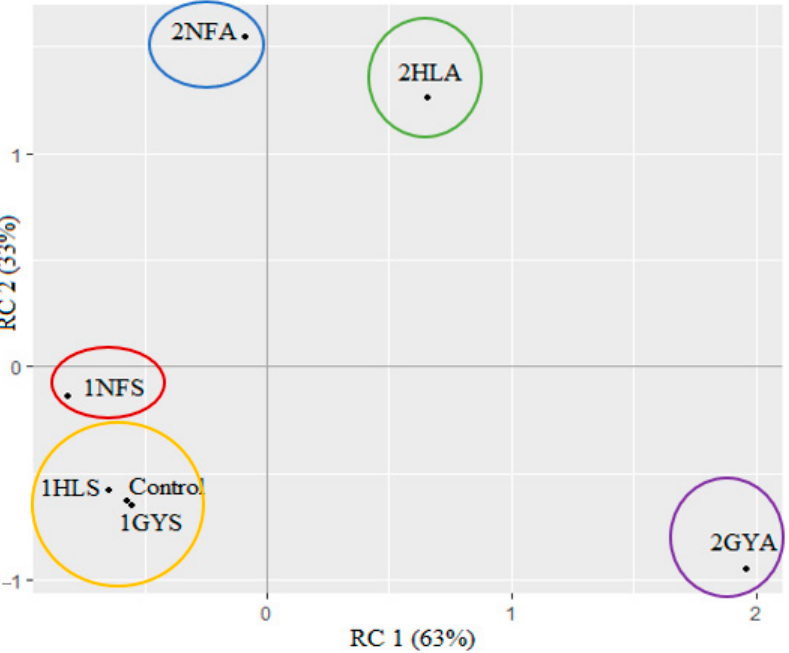
Figure 5. Principal component analysis (PCA) for syrups of sweet and acid whey permeates after second-stage fermentation, evaluated at four sensory attributes’ (sweet, sour, salty and aftertaste) intensities. Commercial glucose-galactose syrup used as a control ( n = 30).